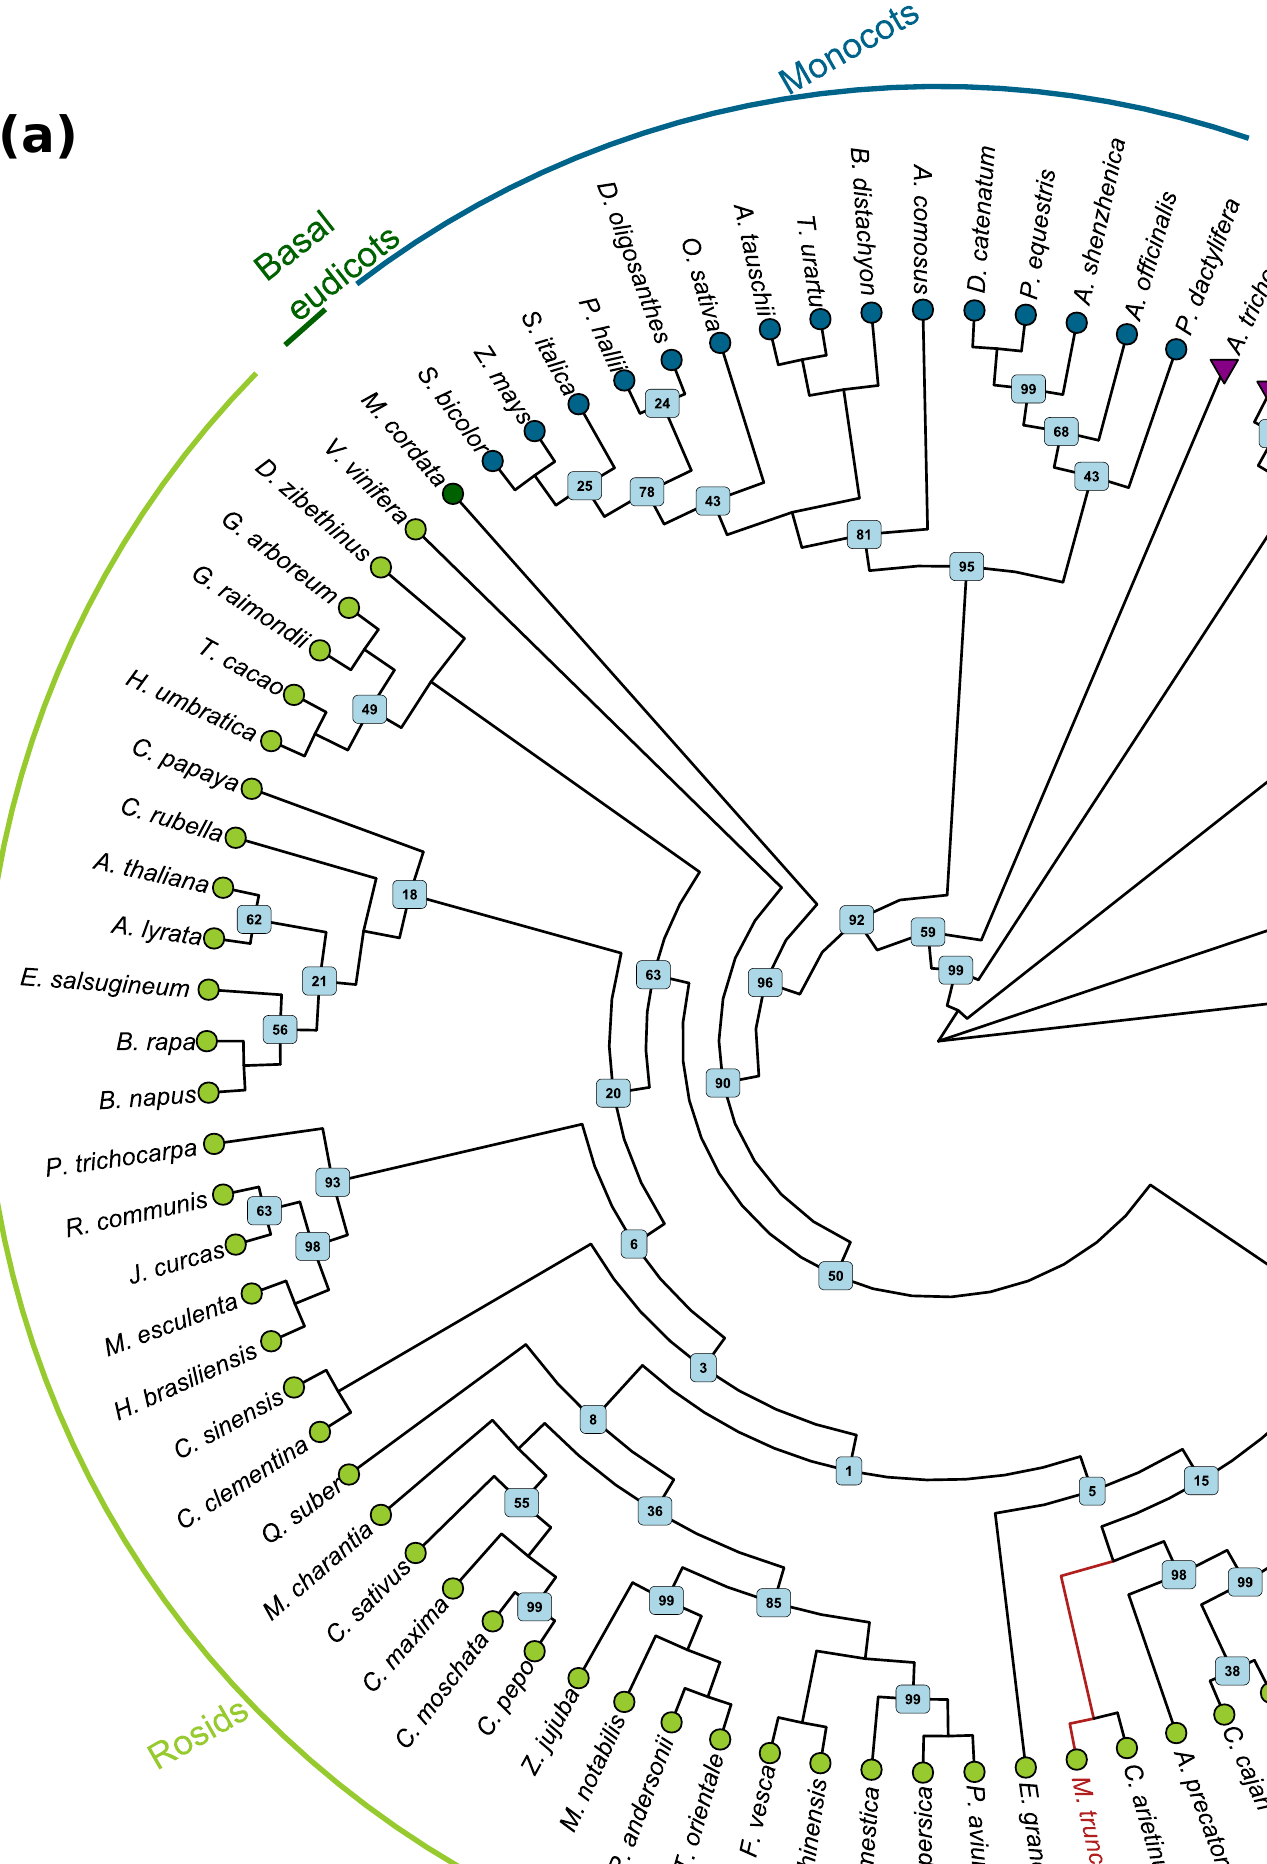
(b) Figure 1. Phylogenetic tree constructed based on the ( a ) TDP1 α and ( b ) TDP1 β sequences. For TDP1 α , 500 bootstrap maximum likelihood tree of 88 protein sequences was used while 36 protein sequences are representative for TDP1 β . Bootstrap values are shown only if lower than 100. The di ff erent clades are marked with di ff erent point and bar colors. M. truncatula branch is highlighted in